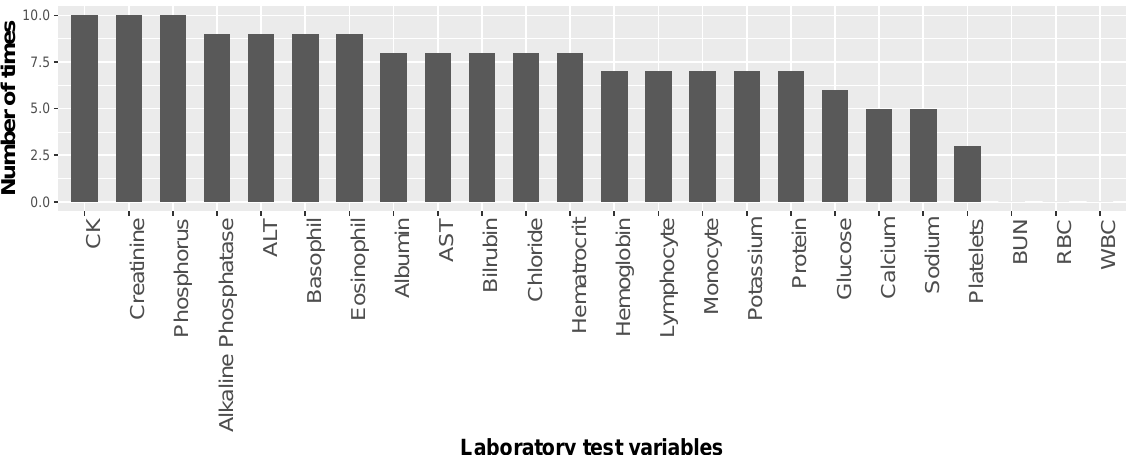
Figure 3. Number of times each of the laboratory test variables was selected in the feature sub-sets for the ten ALSFRS